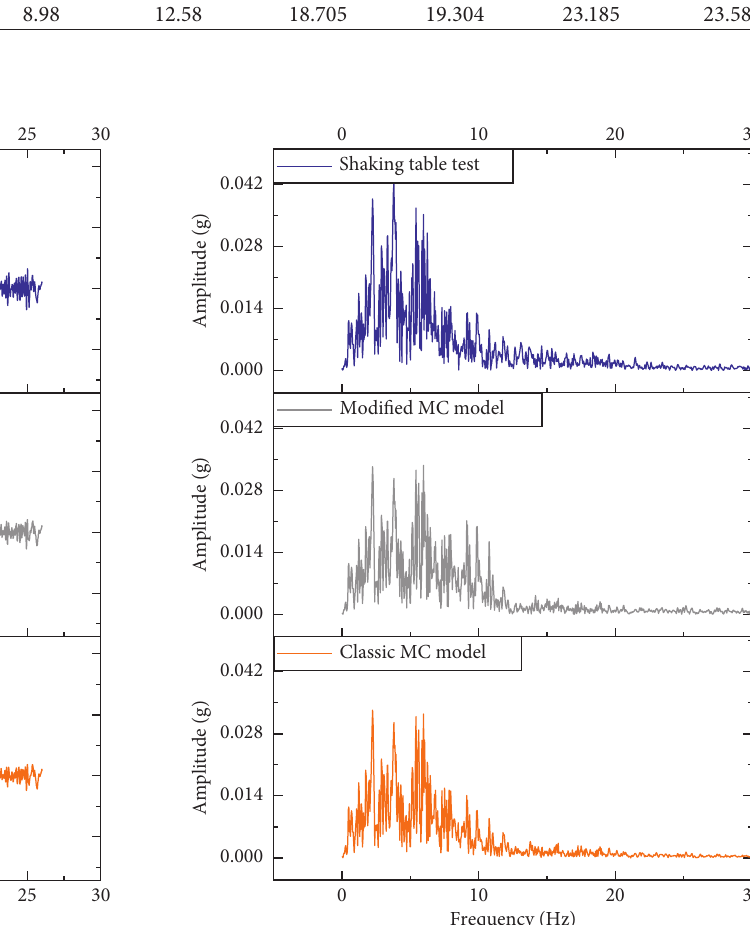
Figure 12: Acceleration time history at point A4H. Figure 13: : Frequency-domain analysis of point A4H.